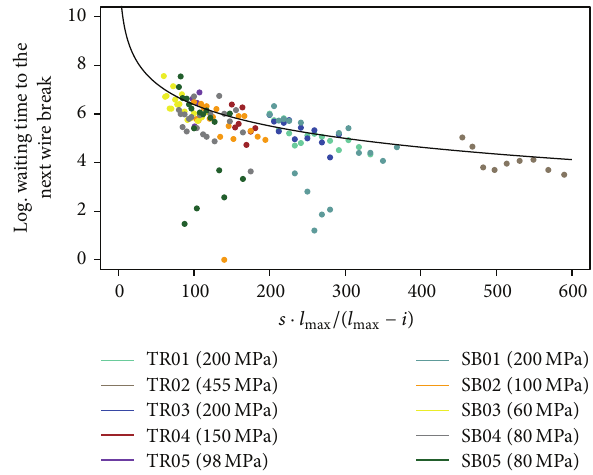
Figure 4: Fitted expectation of the logarithmized waiting times using the Basquin link function.